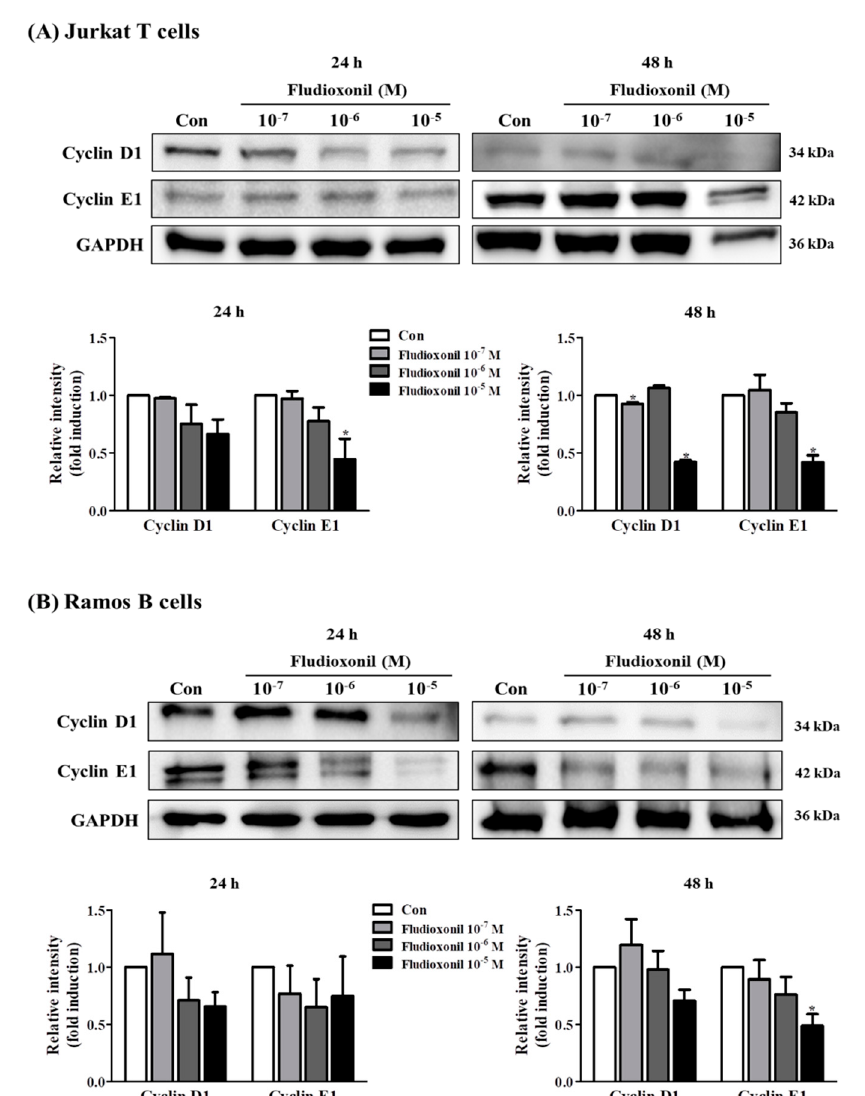
Figure 3. Protein expression of cell cycle-related genes in Jurkat T cells and Ramos B cells by treatment of fludioxonil. ( A ) Jurkat T cells and ( B ) Ramos B cells were treated with 10 − 7 –10 − 5 M fludioxonil for 24 or 48 h. The cell lysates were prepared and the target proteins were analyzed by Western blotting. The protein expression of cell cycle-related genes, such as cyclin E1 and cyclin D1, in protein levels are shown as representative Western blot images. All bands were normalized by GAPDH and presented as % of controls. The value of the control (DMSO) was set as 1 and the values of the treatment groups were indicated as fold induction vs. control. The data are shown as the means ± standard deviation (SD) of three independent experiment. * p < 0.05 as compared with the control.